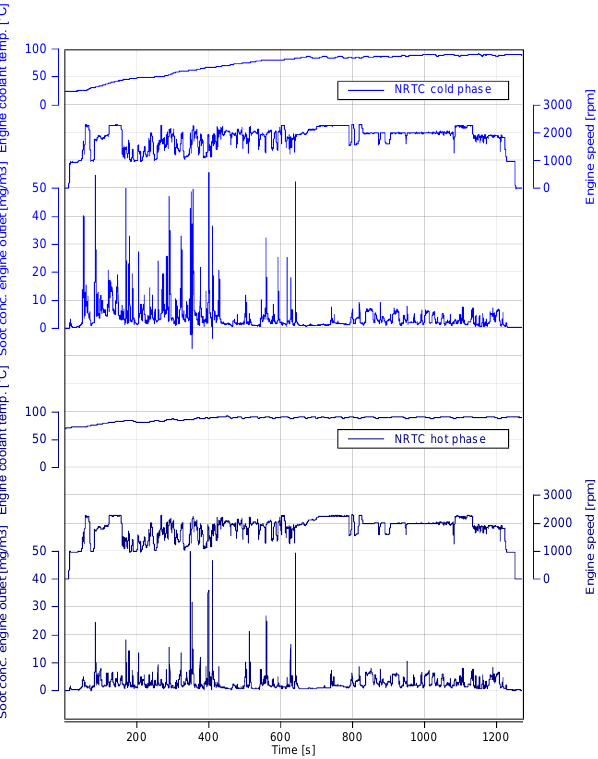
Fig. 8. Soot concentration measurement during the NRTC cold and hot cycles